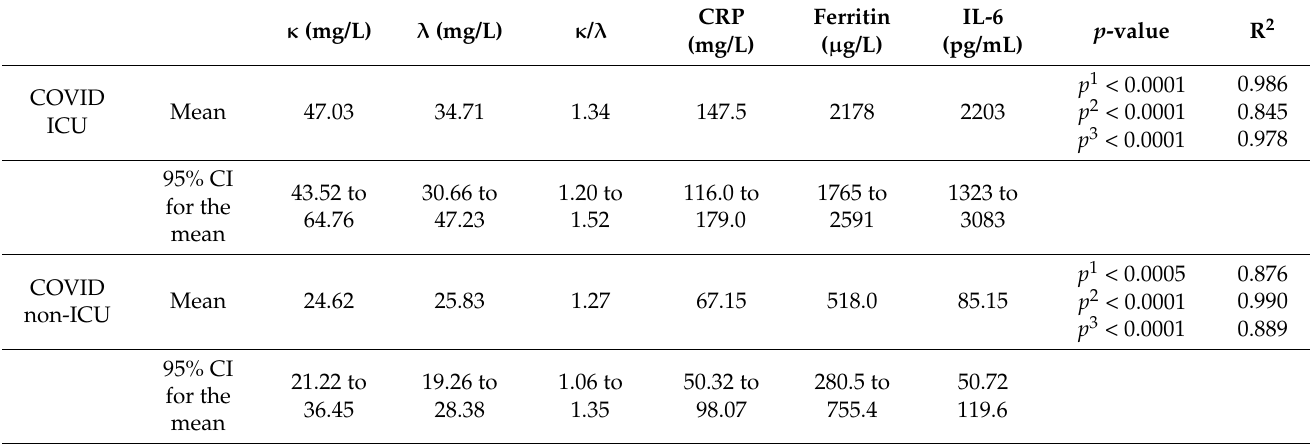
Figure 5. ROC curve analyses of free light chains (( A )—ROC curve κ FLCs; ( B )—ROC curve λ FLCs; ( C )—ROC curve κ / λ ratio). Table 5. Correlation of the increased C-reactive protein, ferritin, and IL-6 concentrations with the increased secretion of free light chains during COVID-19 ( n =